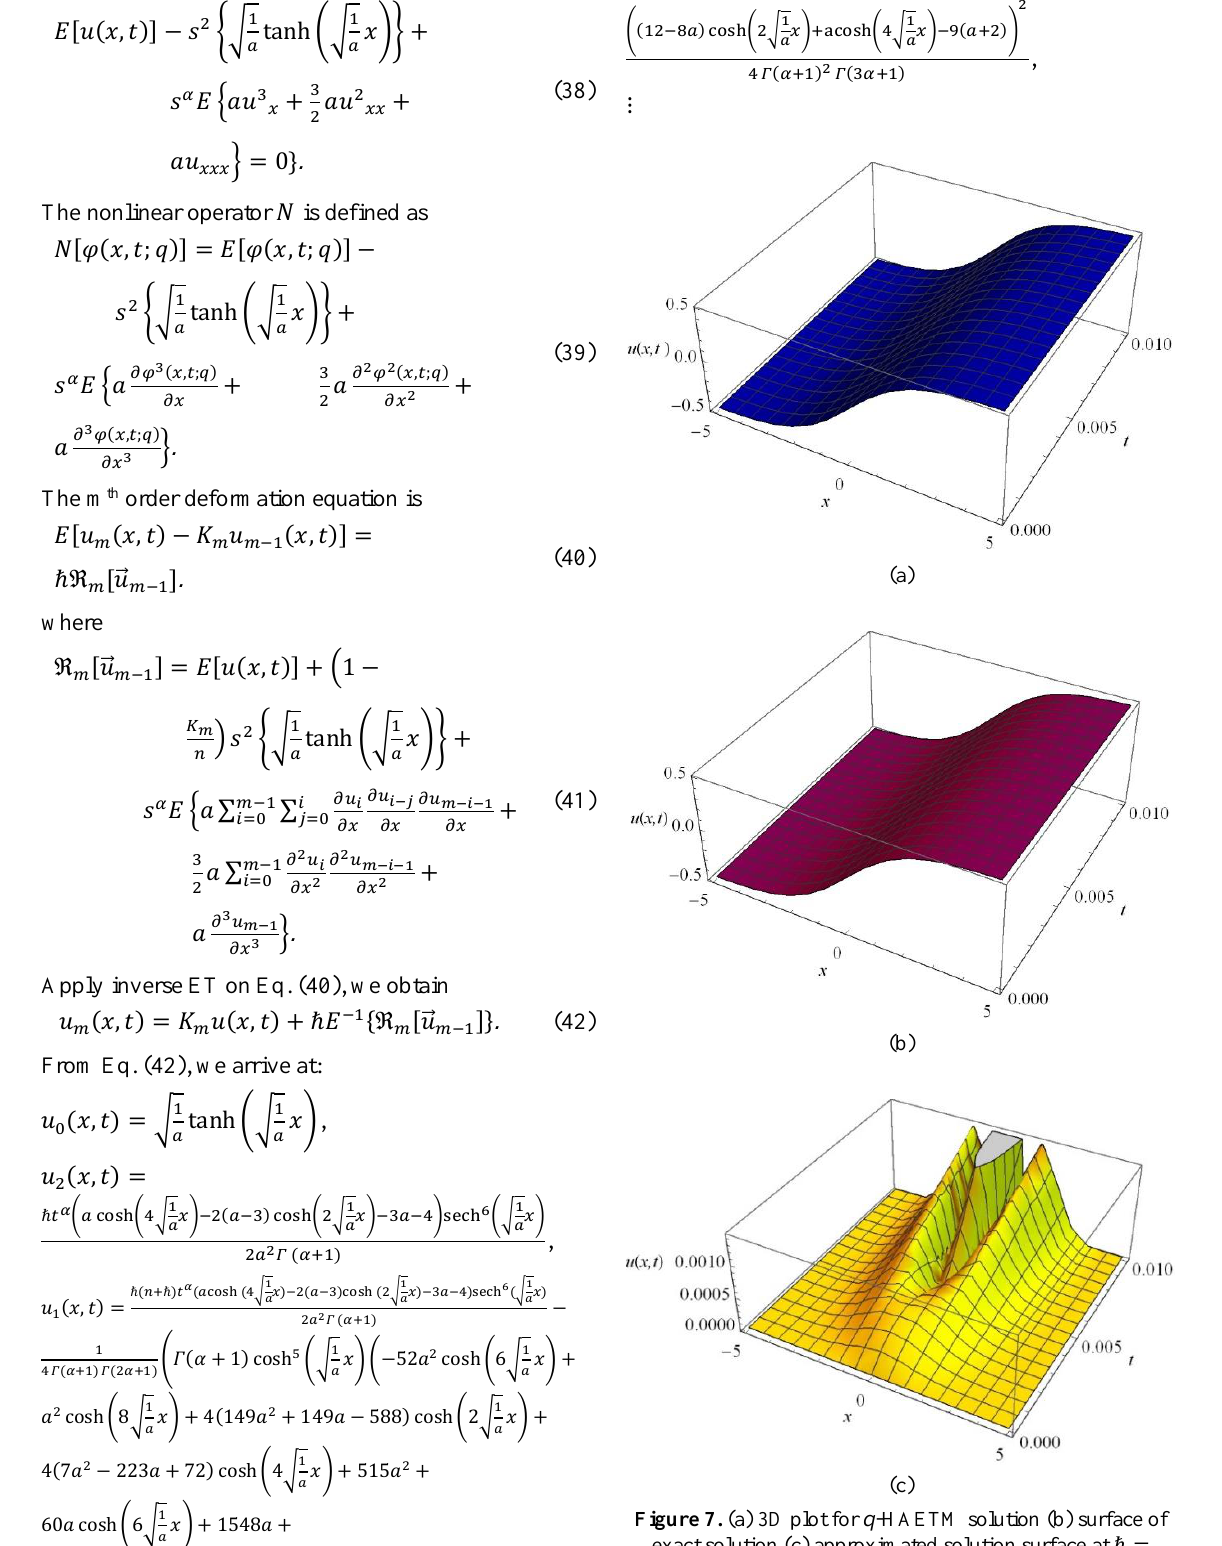
Figure 7. (a) 3D plot for q -HAETM solution (b) surface of exact solution (c) approximated solution surface at ℏ = −1.858, 𝑎 = 4,𝑛 = 1 and 𝛼 = 1